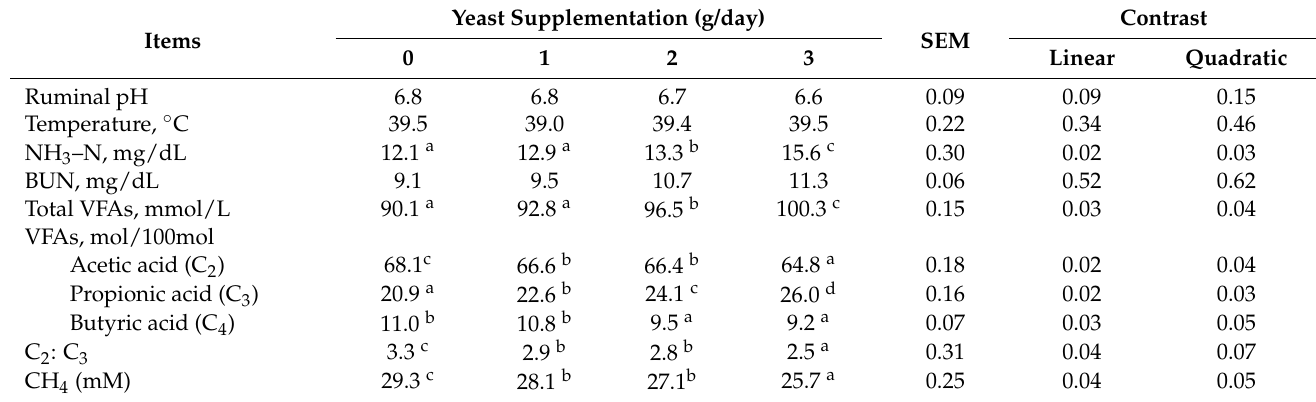
Table 3. Effect of yeast supplementation on fermentation characteristics and blood urea nitrogen in Thai native beef